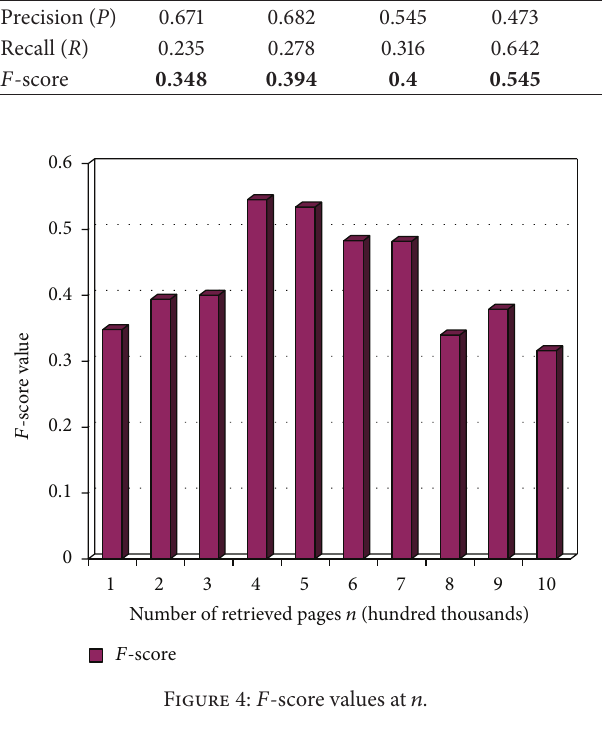
Figure 4: 𝐹 -score values at 𝑛 .